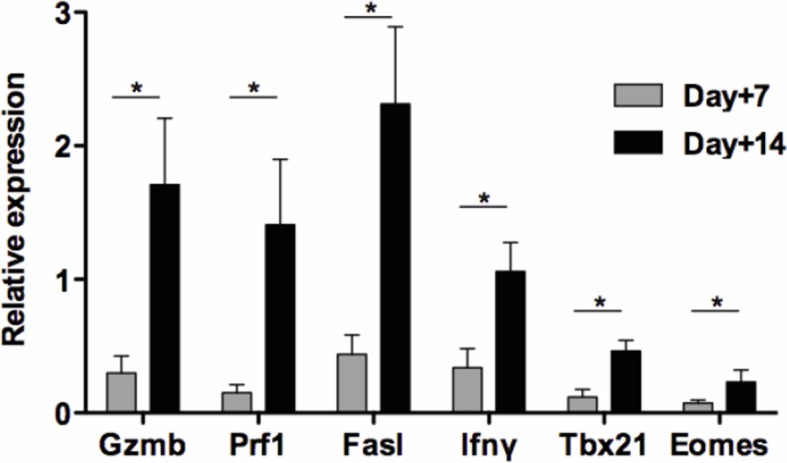
Kinetics of intragraft effector gene expression in untreated recipients.Pancreatic islets from BALB/c mice were transplanted under the kidney capsule of C57BL/6 recipients. Allografts were recovered on day 7 and 14 post-transplant and expression Gzmb, Prf1, Fasl Ifnγ, Tbx21 and Eomes mRNA was analyzed by RT-qPCR (n = 4-5) (*p<0.05).